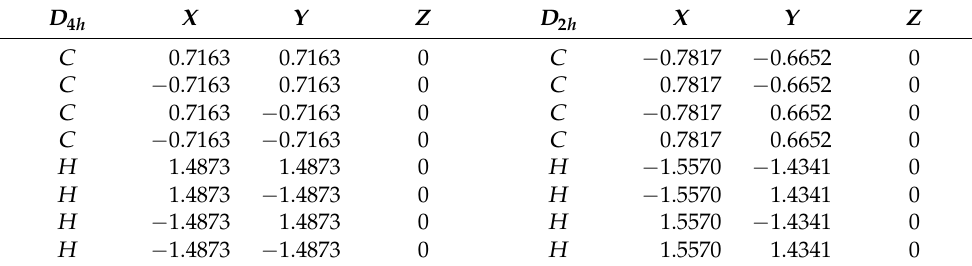
Table A1. Cyclobutadiene.